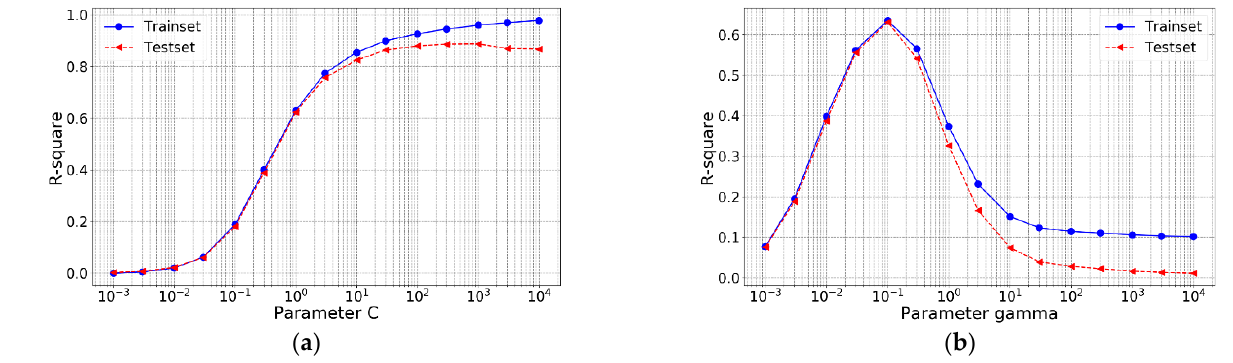
Figure 4. R-square of SVR under different hyperparameters: ( a ) different C and ( b ) different γ .